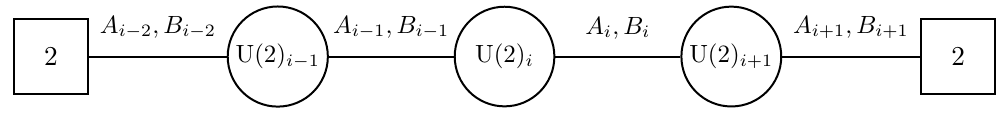
Figure 7 . U(2) nodes in the D N